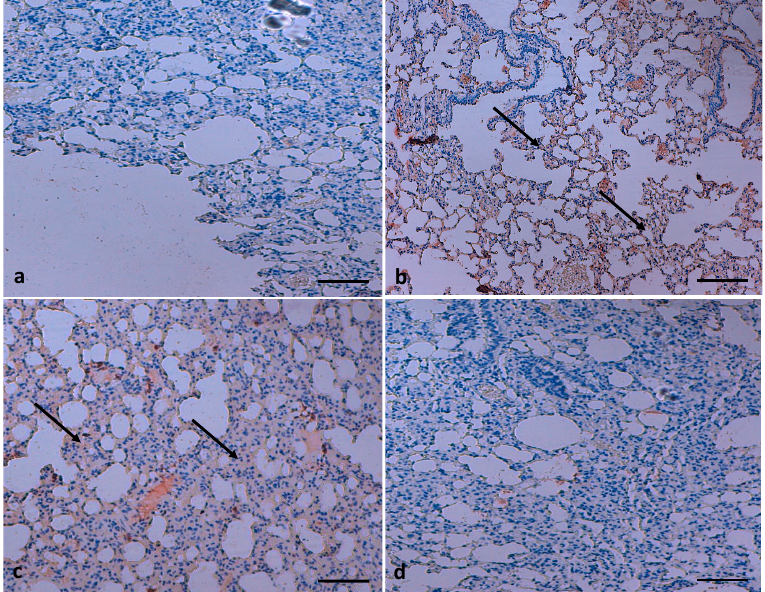
Figure 9. NF- κ B protein expressional analysis. ( a ) The control rats did not express this protein; ( b ) the group treated with B(a)P only displayed high expression of NF- κ B, the arrow indicates cytoplasmic positivity of NF- κ B ( c ) the expression of this marker protein was reduced in animals co-treated with both B(a)P and TQ together, the arrow indicates cytoplasmic positivity of NF- κ B ( d ) the animals treated with only TQ did not show any expression. (Scale bar = 100 µ m.)